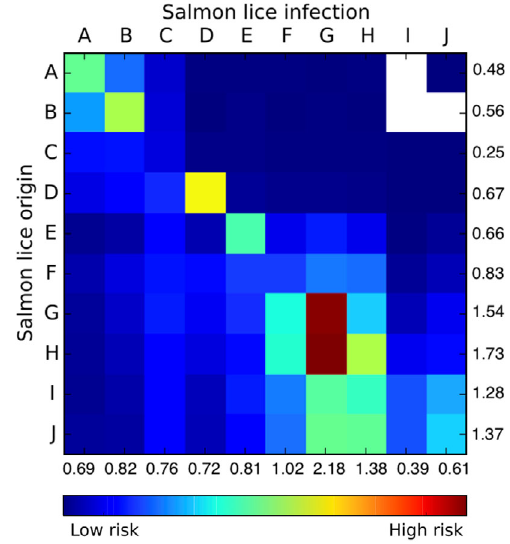
Fig. 11. Blue markers show mean and median dispersion distances of infectious salmon lice Lepeophtheirus salmonis . Blue error bars: 25 th and 75 th percentiles. Red crosses: the area in which 95% of the infection pressure occurs